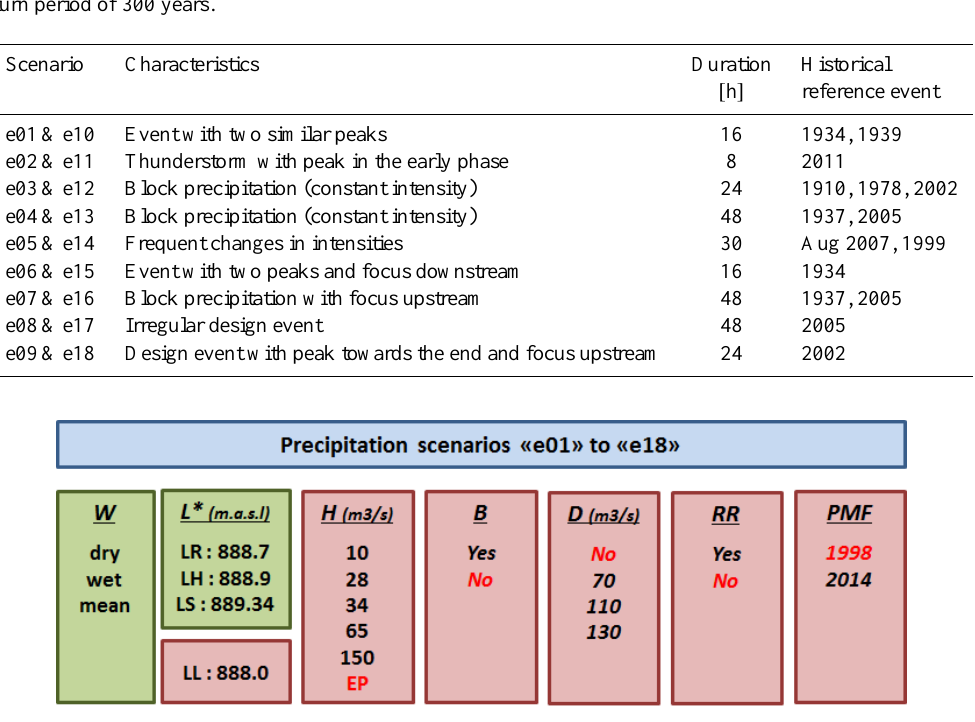
Table 1. Precipitation scenarios. e01 to e09 represent rainfall events of different duration with a return period of 100 years, while e10 to e18 represent the return period of 300 years.